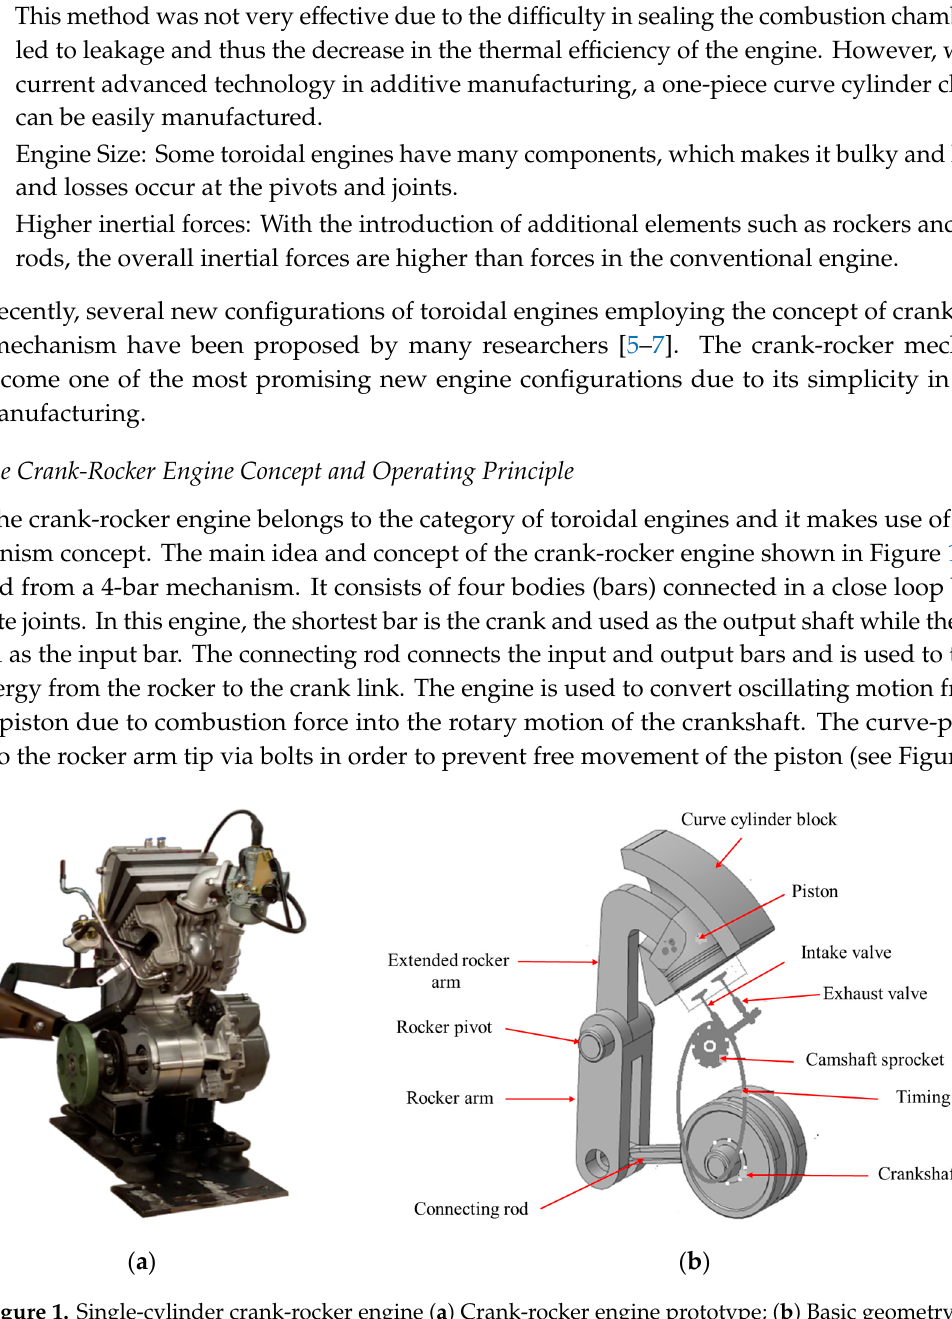
Figure 1. Single-cylinder crank-rocker engine ( a ) Crank-rocker engine prototype; ( b ) Basic geometry of the crank-rocker engine.